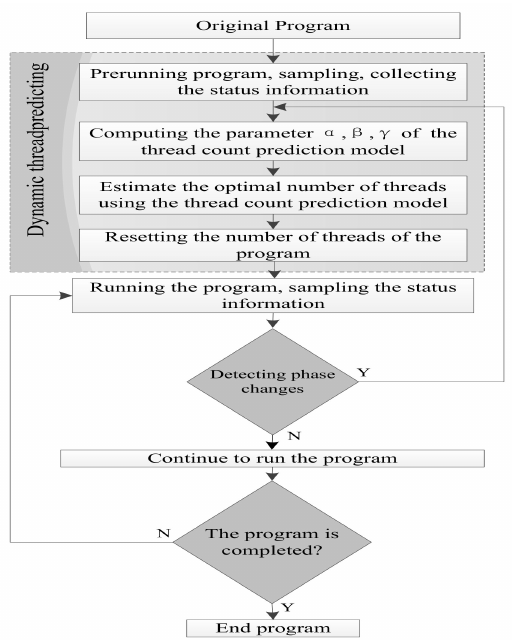
Figure 2. Dynamic predictive thread mapping